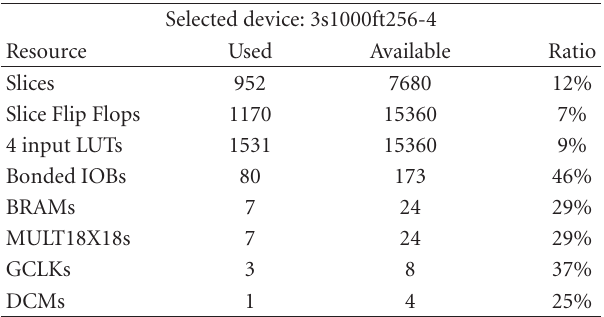
Table 4: Hard-Soft solution